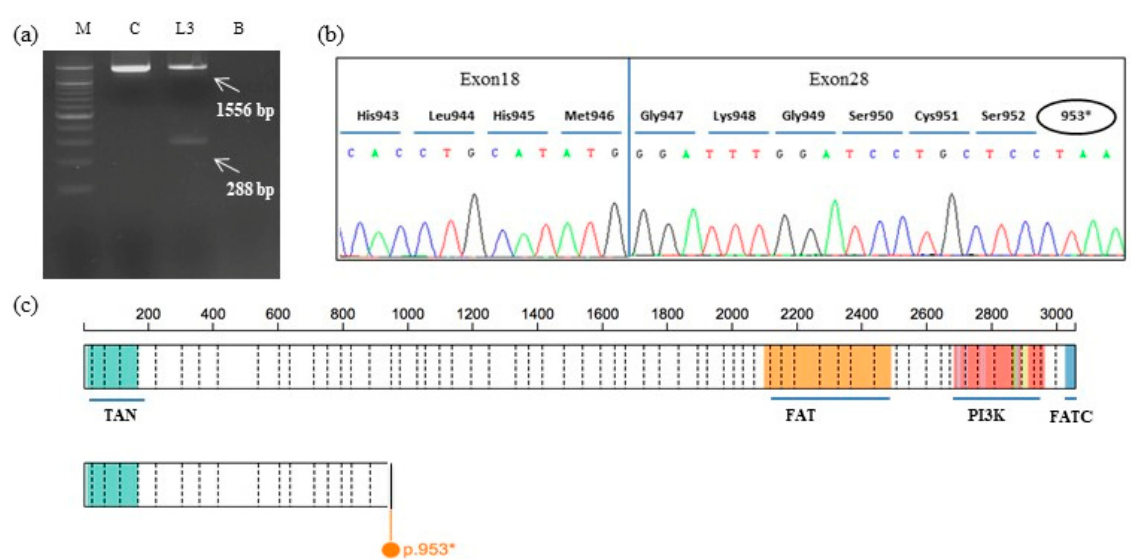
Figure 3. Results from messenger RNA (mRNA) analysis. ( a ) A single PCR fragment of 1556 bp was obtained from the complementary DNA (cDNA) of the wild-type control, while two fragments of 1556 and 288 bp were amplified using the cDNA of the patient. M: marker, C: cDNA wild-type control, Lane 3: patient; B: blank. ( b ) Electropherogram showing the sequence of the PCR product of 288 bp, containing the expected deletion. Sequencing analysis revealed a wild-type sequence until the nucleotide c.3223G (NM_000051.3) of the ATM gene in exon 18 (Met946). The following sequence corresponded to ATM exon 28 starting from the nucleotide c.4495G (NM_000051.3) (Gly947). A stop codon at amino acid 953 (953*) produced a truncated protein. ( c ) The figure shows the schematic maps of the full-length ATM protein (3056 amino acids; top) and the predicted truncated ATM protein (953 amino acids; bottom). Main protein domains are represented by colored areas and described, whereas the vertical lines represent exon boundaries (starting from exon 2). TAN: Tel1/ATM N-terminal motif; FAT: Frap–Atm–Trrap domain; PI3K: Phospho-Inositide 3-Kinase domain; FACT: Frap–Atm–Trrap Carboxy-Terminal domain (https://proteinpaint.stjude.org/).